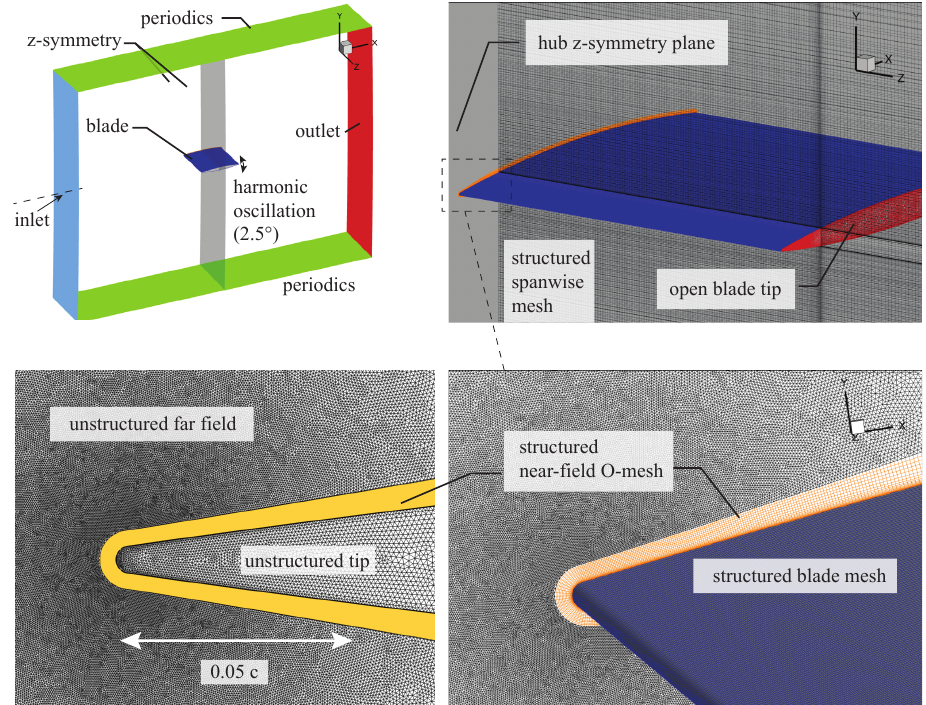
Figure 2. Visualization of numerical domain and mesh